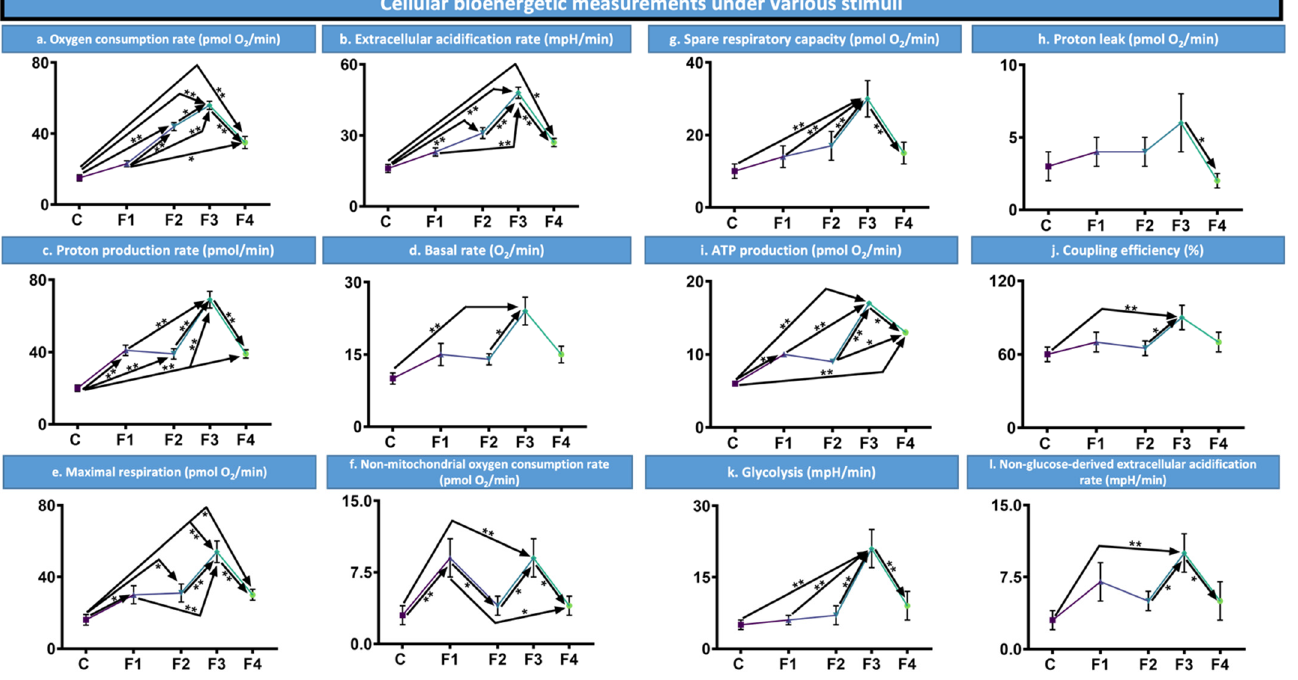
Figure 4. Cellular bioenergetic measurements under various stimuli. ( a ). Oxygen consumption rate (pmol O 2 /min). ( b ). Extracellular acidification rate (mpH/min). ( c ). Proton production rate (pmol/min). ( d ). Basal rate (O 2 /min). ( e ). Maximal respiration rate (pmol O 2 /min). ( f ). Non-mitochondrial oxygen consumption rate (pmol O 2 /min). ( g ). Spare respiratory capacity (pmol O 2 /min). ( h ). Proton leak (pmol O 2 /min). ( i ). ATP production rate (pmol O 2 /min). ( j ). Coupling efficiency (%). ( k ). Glycolysis (mpH/min). ( l ). Non-glucose-derived extracellular acidification rates (mpH/min). Assessed on formulations 1 to 4 with unencapsulated MIN6 pancreatic β -cells as the control (C). Presented as Mean ± SEM, with arrows used to denote any statistical significance between data points. * p < 0.05, ** p < 0.01.